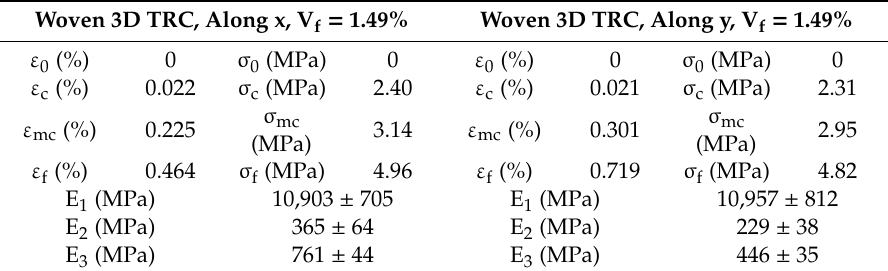
Table 5. Averaged tensile experimental parameters for the woven 3D TRC layup. Woven 3D TRC, Along x, V f = 1.49% Woven 3D TRC, Along y, V f =